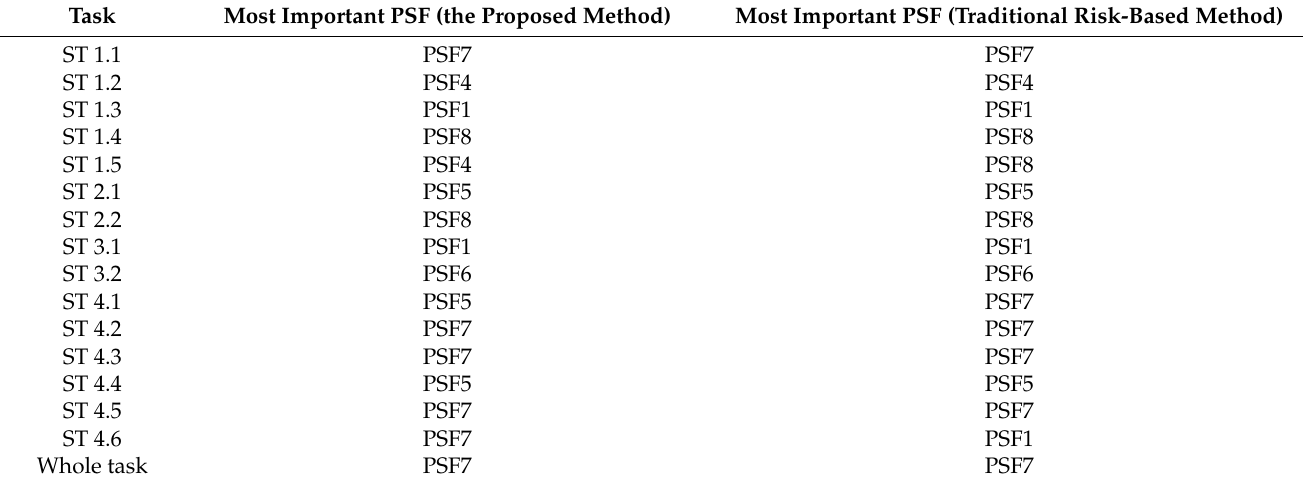
Table 16. The most important PSF in each